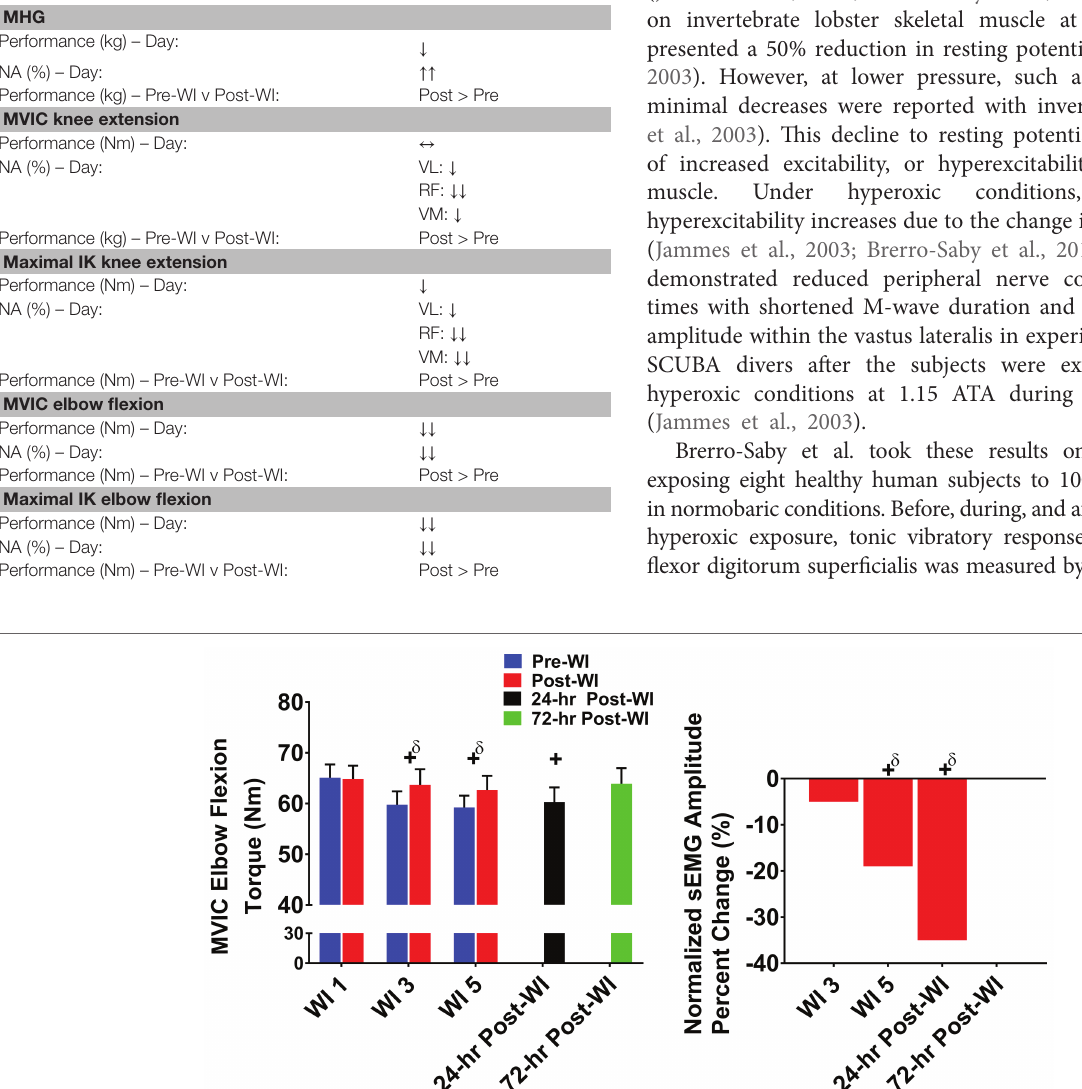
TABLE 2 | Direction of change for muscular performance variables and associated p . A ↑ or ↓ is shown for a p < 0.05, and ↑↑ or ↓↓ is shown for p < 0.001. The overall values show the differential effects of hyperoxic water immersions (WIs). Exercise Summary of